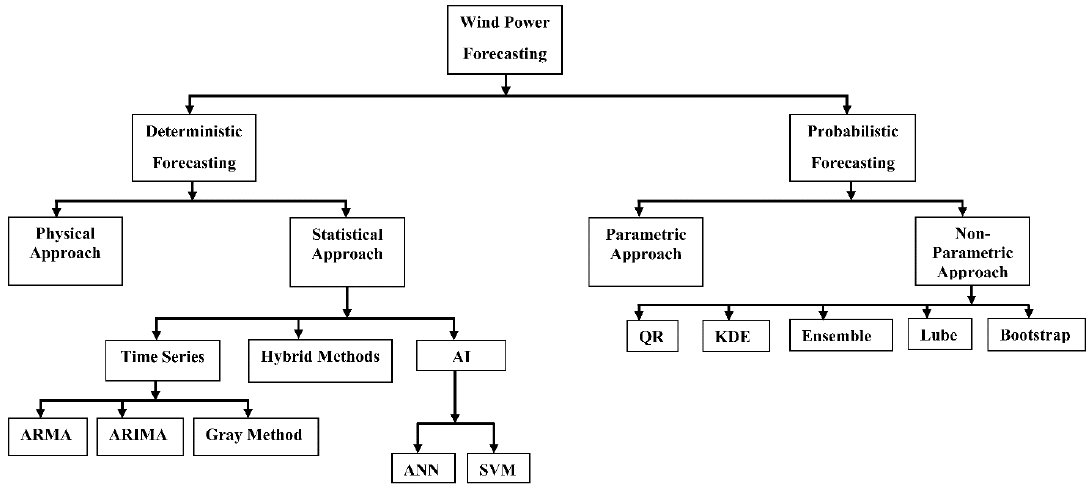
Figure 1. Major types of methods used for forecasting wind speed .